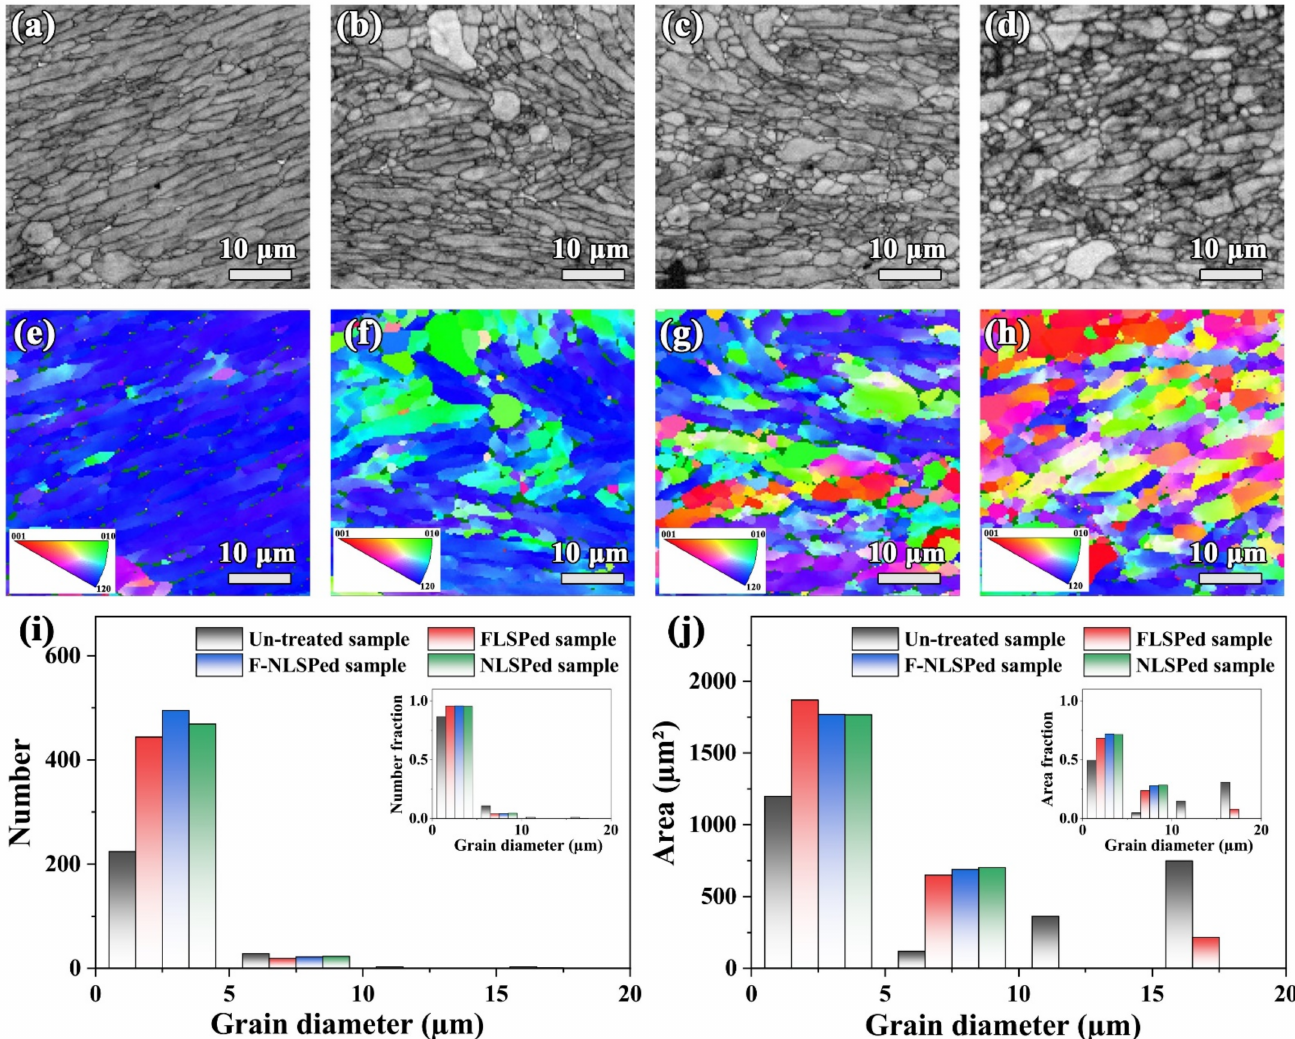
Figure 3. EBSD analyses for in-depth microstructural changes of un-treated and LSPed samples. BC images of in-depth microstructures of ( a ) un-treated, ( b ) FLSPed, ( c ) NLSPed, and ( d ) F-NLSPed samples; IPF mappings of ( e ) un-treated, ( f ) FLSPed, ( g ) NLSPed, and ( h ) F-NLSPed samples; Histogram comparisons of ( i ) the number and ( j ) the area of grains for un-treated and LSPed